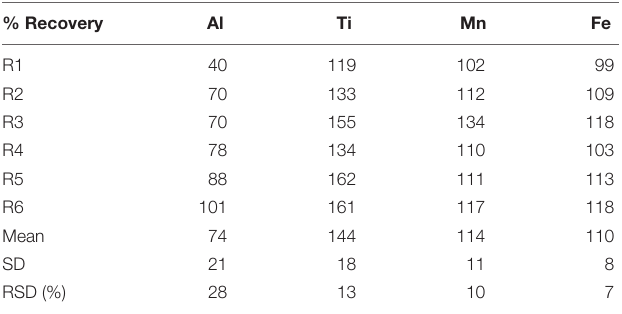
µ g/l In as an internal standard and were prepared